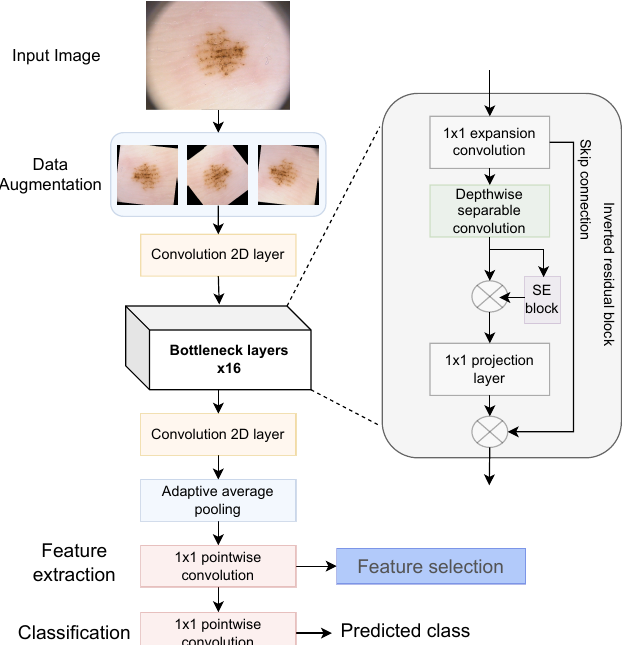
Figure 3. The architecture of the model used for feature extraction. MobileNetV3 was fine-tuned to boost performance in medical image classification, where the learned activation values of a certain layer were stored as vectors representing the input images. The model was composed of 16 bottleneck layers [56] containing inverted residual blocks, which were kept fixed during the fine-tuning process, and only the top layers were used to learn the characteristics of the training samples from each medical dataset. The inverted residual blocks’ core component was the depthwise separable con- volution layer. In addition, in a certain layer, the depthwise separable convolution layer could contain a squeeze-and-excite (SE) block [53], which was used for relevant feature selection on a channel-wise basis. A 3 × 3 depthwise separable convolution replaced the point-to-point convolution by using one filter for each input channel, which helped to reduce the model’s computational complexity. The 1 × 1 point-wise convolution was used on all of the channels in the inverted residual block to convert the output into a linear combination, which can be seen as a multilayer perceptron (MLP). The depthwise sepa- rable convolution block consisted of four different components placed in the following order: ( 1 × 1 Conv ) → ( BN ) → ( ReLU / h - swish ) → ( 3 × 3 Conv ) → ( BN ) → ( ReLU / h - swish ) → ( 1 × 1 Conv ) → ( BN ) → ( ReLU / h - swish ) . Two types of activation functions were used interchangeably in the model; these were the rectified linear unit (ReLU) and a function recently proposed by [57,58] named h - swish . The h - swish activation function integrates the ReLU6 activation function to reduce the computational resources on small devices and replace the sigmoid function [57], as defined in Equation